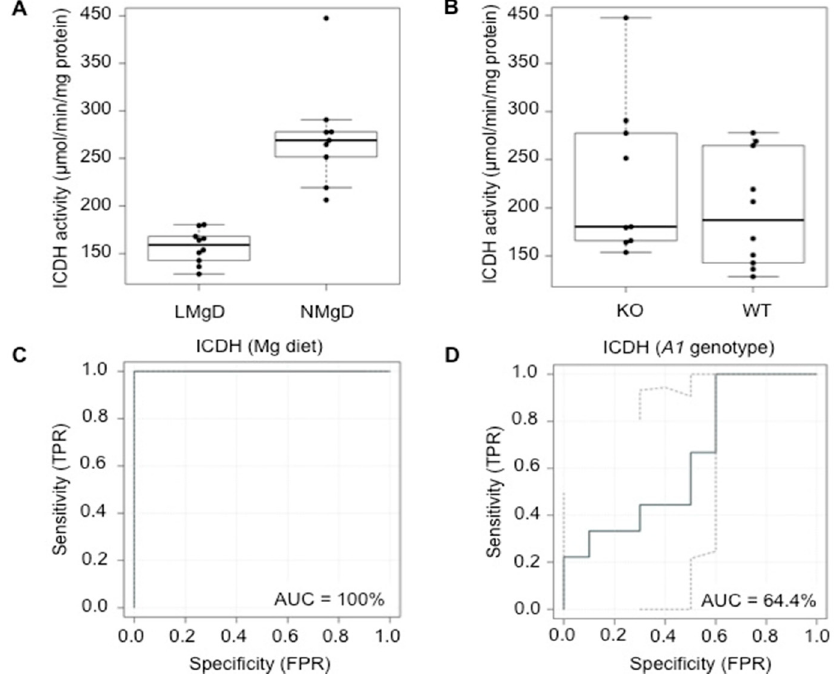
Figure 2. Impact of dietary Mg content and of Slc41a1 genotype on activity of isocitrate dehydrogenase (ICDH) in murine cardiac mitochondria. ( A ) Box-and-whisker plot overlaid with dot plot showing the influence of dietary Mg content (LMgD vs. NMgD) and ( B ) Slc41a1 genotype ( Slc41a1 − / − vs. Slc41a1 +/+ ) on ICDH activities in murine mitochondria. For both, A and B, the original source data and corresponding medians are indicated for each group. ( C , D ) Empirical ROC (receiver operating characteristic) curves with the area under the ROC curve (AUC) for ( C ) the type of Mg diet as predictor of ICDH activity and ( D ) the Slc41a1 genotype as predictor of ICDH activity. Abbreviations: A1 , Slc41a1 ; FPR, false-positive rate; KO, knock-out; TPR, true-positive rate; WT, wild-type.